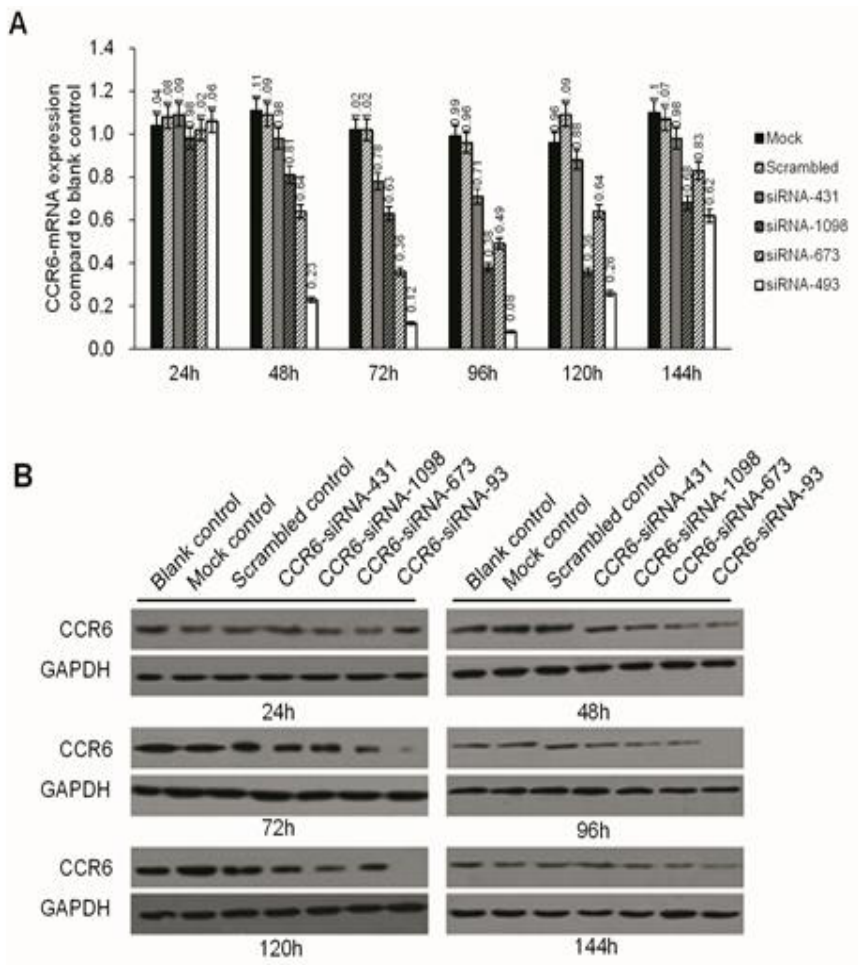
Figure 3. CCR6 mRNA and protein level in HCCLM6 cells were detected by real-time PCR after transfection for 24, 48, 72, 96, 120 and 144 h. ( A ) All the interference groups have various degrees of depressive effects after transient transfection for 48 h, and the depressive effect reached a peak after 72–96 h. The level of CCR6 mRNA in the CCR6-siRNA-493 group knockdown was most ( p < 0.05). The mock group is used as reference; ( B ) The level of CCR6 protein in the CCR6-siRNA-493 group is depressed most ( p < 0.05) and reached the peak after 96–120